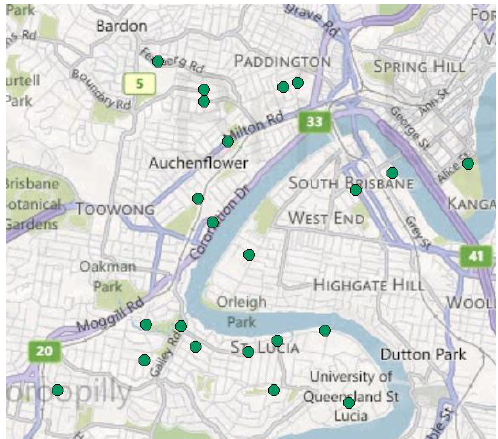
Figure 4. Distribution of the surveyed flood heights over the study area (© Microsoft Corporation 2012 and © NAVTEQ 2010)